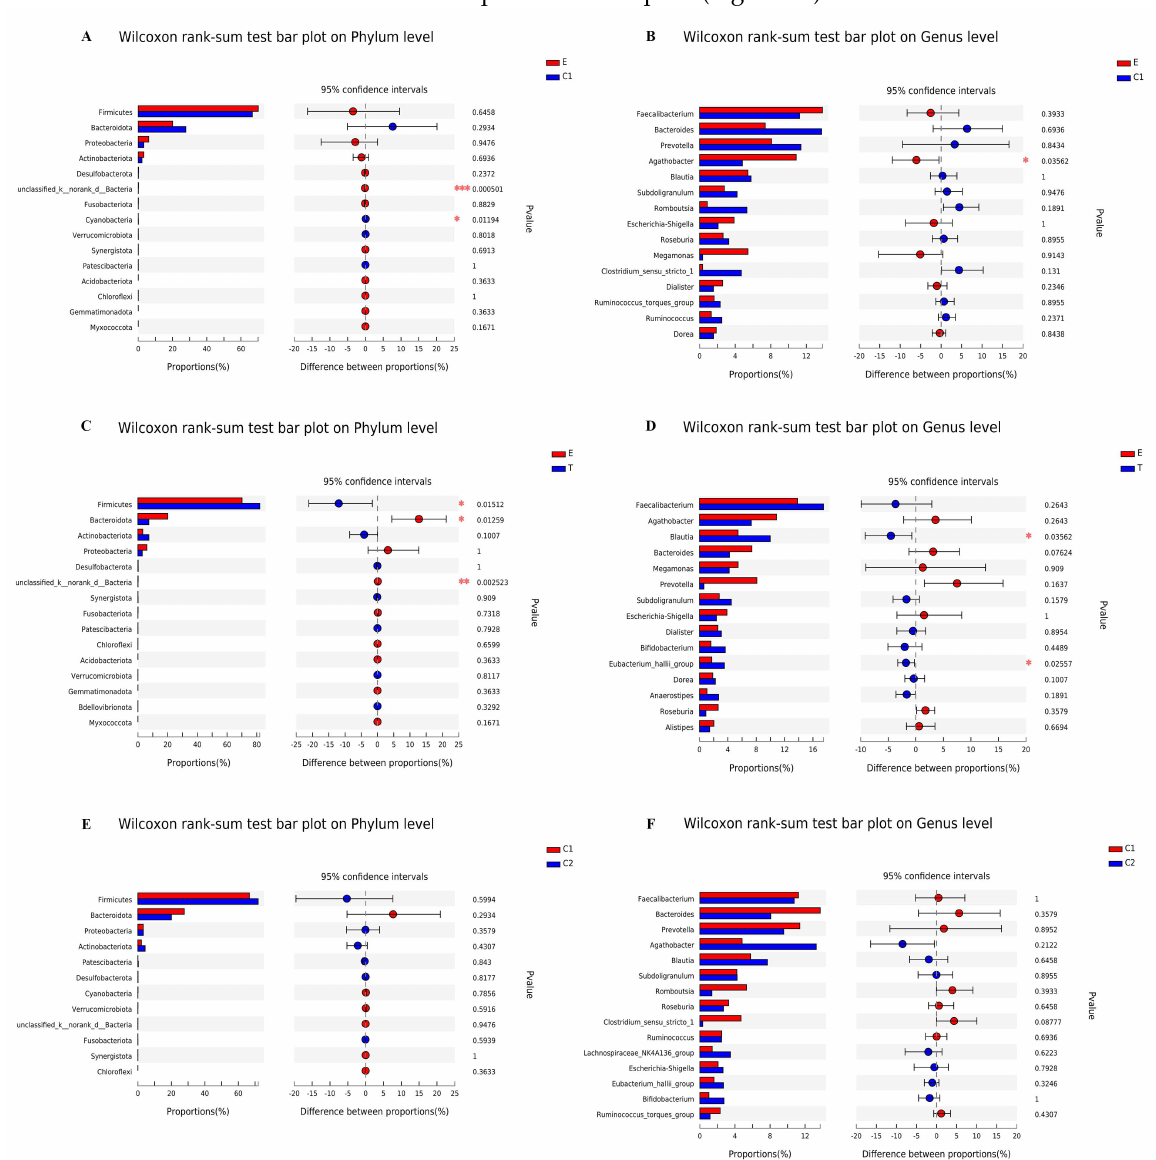
Figure 3. Evaluating the significance level of the difference in species abundance at the level of phylum or genus between groups before and after exercise intervention. ( A , C , E ) The phylum level to compare the difference in gut microbiota between groups. ( B , D , F ) The genus level to compare the difference in gut microbiota between groups. Different colors represent different groups. E: experimental group before exercise intervention; T: experimental group after exercise inter- vention; C1: control group before exercise intervention; C2: control group after exercise intervention. * p < 0.05, ** p < 0.01, *** p <